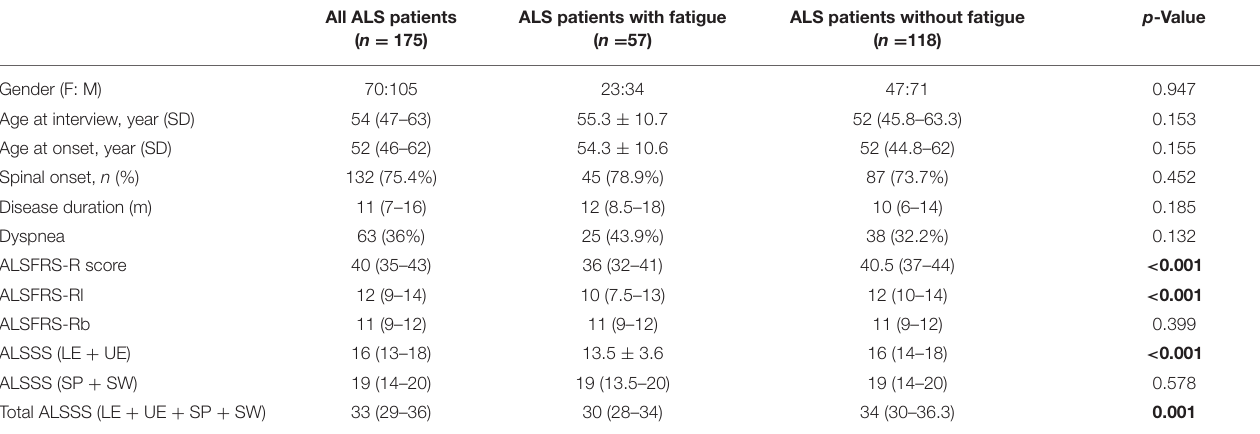
TABLE 2 | Demographic and clinical characteristics of patients with ALS with fatigue or without fatigue.